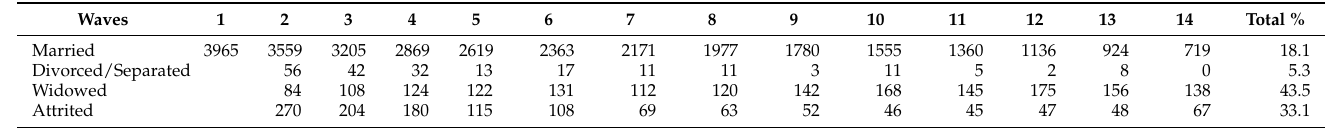
Table 1. Marital Status by Wave among Couples without Activities of Daily Living Disability at Wave